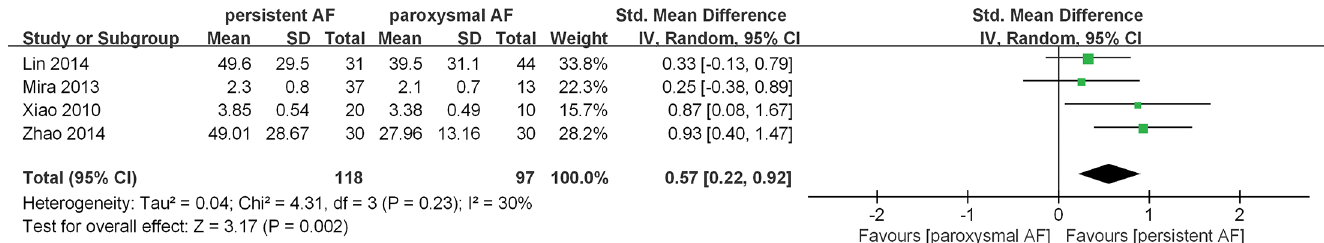
Fig 4. Forest plot of the association between the plasma level of TGF- β 1 and the two different types of AF. AF, atrial fibrillation; CI, confidence interval; SD, standard deviation.